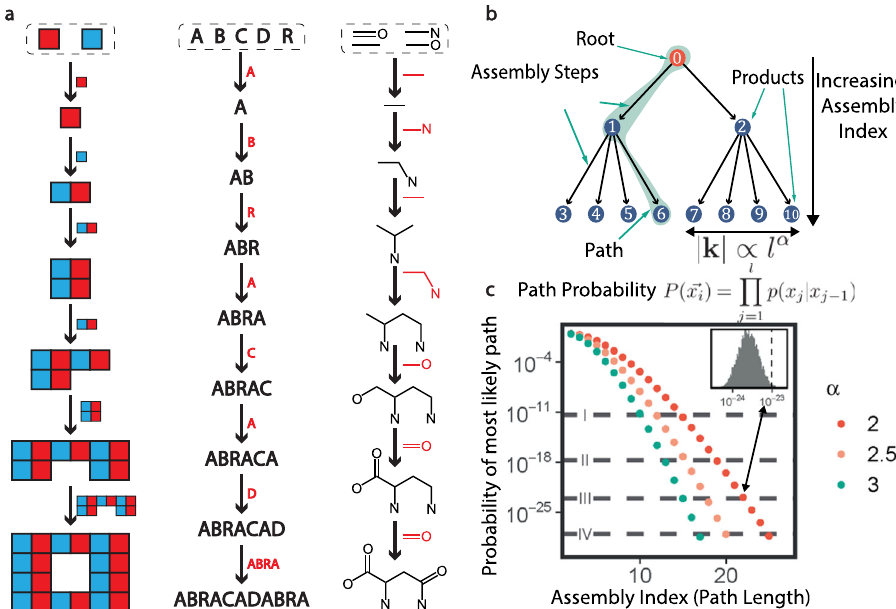
Fig. 1 Assembly pathways. a In analyzing the assembly pathways of an object, we start with its basic building blocks, which are the shared set of objects that can construct our target object and any other object within the class of objects. The Assembly index of an object is de fi ned as the smallest number of joining operations required to create the object using this model. b We can model the assembly process as a random walk on weighted trees where the number of outgoing edges (leaves) grows as a function of the depth of the tree, due to the addition of previously made sub-structures. By generating several million trees and calculating the likelihood of the most likely path through the tree, we can estimate the likelihood of an object forming by chance as a function of the number of joining operations required (path length). c The probability of the most likely path through the tree as a function of the path length decreases rapidly. The colors indicate different assumptions about the chemical space. For comparison, the dashed lines indicate the ratio of (I) one star in the entire milky way, 1:10 11 , (II) one gram out of all of Earth ’ s biomass, 1:10 17 , (III) one in a mole, 1:10 23 , and (IV) one gram out of Earth ’ s mass (1:10 29 ). Note on this plot the path probability of the formation of Taxol would vary between 1:10 35 to 1:10 60 with a path length of 30 and the amount of chemical predisposition is varied with alpha biasing the effective selectivity between 50 – 99.9% at each step